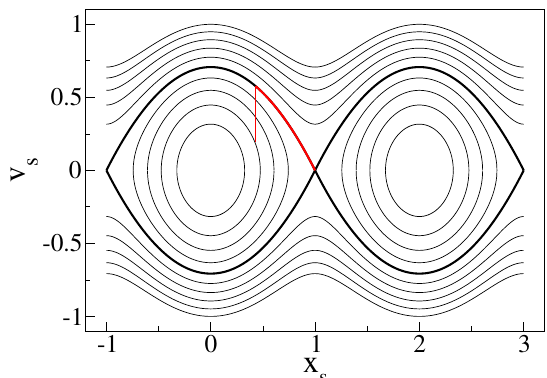
Figure 4: Phase portrait for a particle in the potential of Eq. 1, with ∆ U = 1 / 4 and L = 2. Lines correspond to E / ∆ U = 0.2,0.4,...,2. The black bold line indicates the separatrix, E / ∆ U = 1. The function f has a singularity corresponding to the flights on the separatrix that terminate = 1. The figure illustrates the evolution of a particle on the top of the potential barrier, x e = 0.431 following which it jumps on the of energy E / ∆ U = 0.4 undergoing a collision in x s = 1 in a time ∆ t → ∞ separatrix and reaches x e